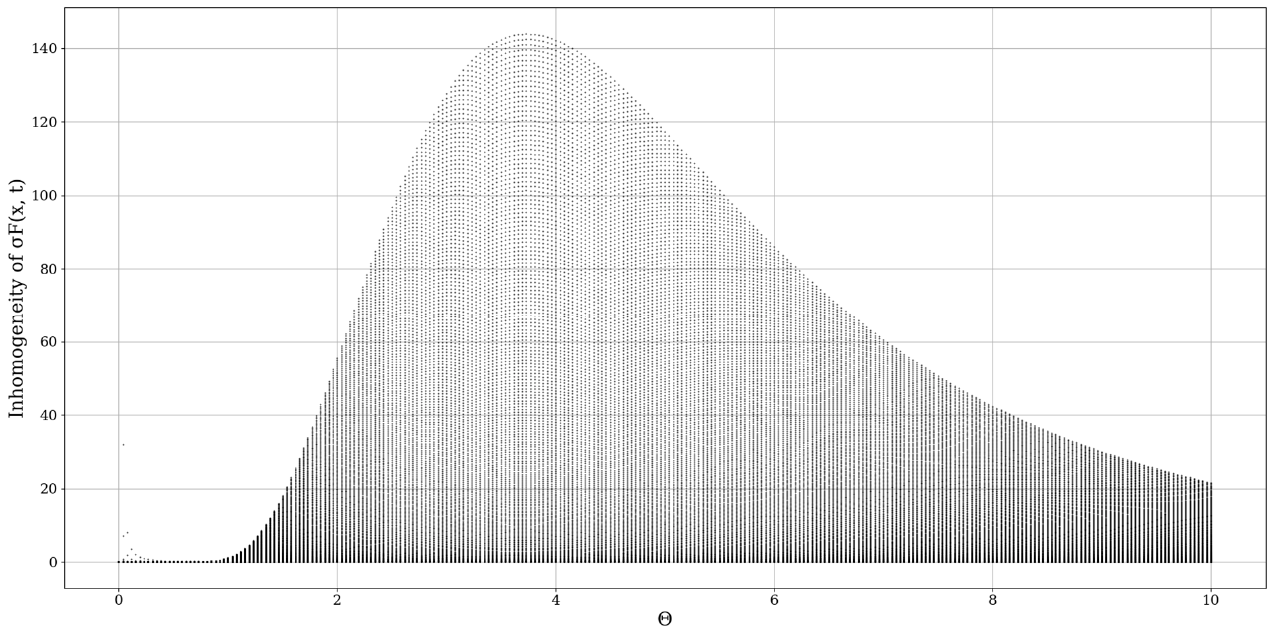
(cid:104)| σ | (cid:48) 2 (cid:105) example plot with θ as control parameter; ξ = 0.5; µ = 1. Figure 5. 〈|σ (cid:2890) (cid:3364)(cid:3364)(cid:3364)| (cid:4593)(cid:2870) 〉 example plot with θ as control parameter; ξ = 0.5 ; μ = 1 . Figure 5. F